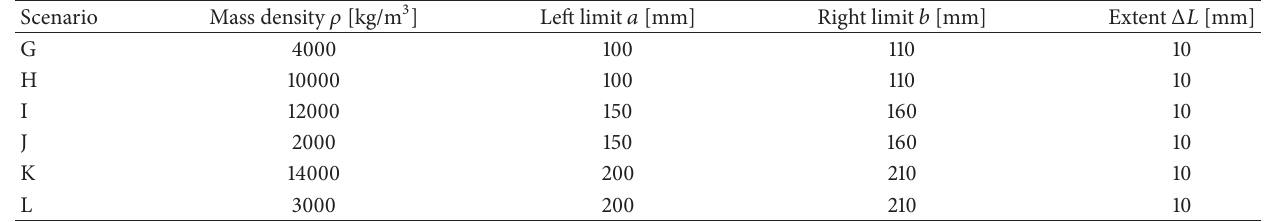
Table 2: Parameters reflecting the segments affected by mass alteration, slim regions.